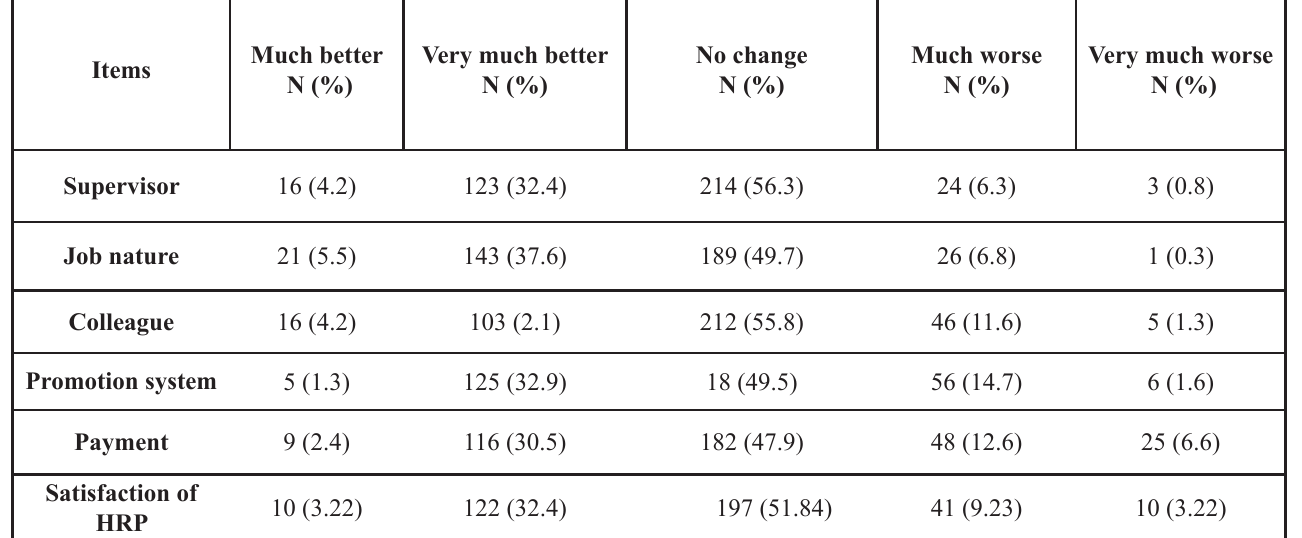
Table 4. Impact of HRP on the dimensions of job satisfaction from nurses’ viewpoints